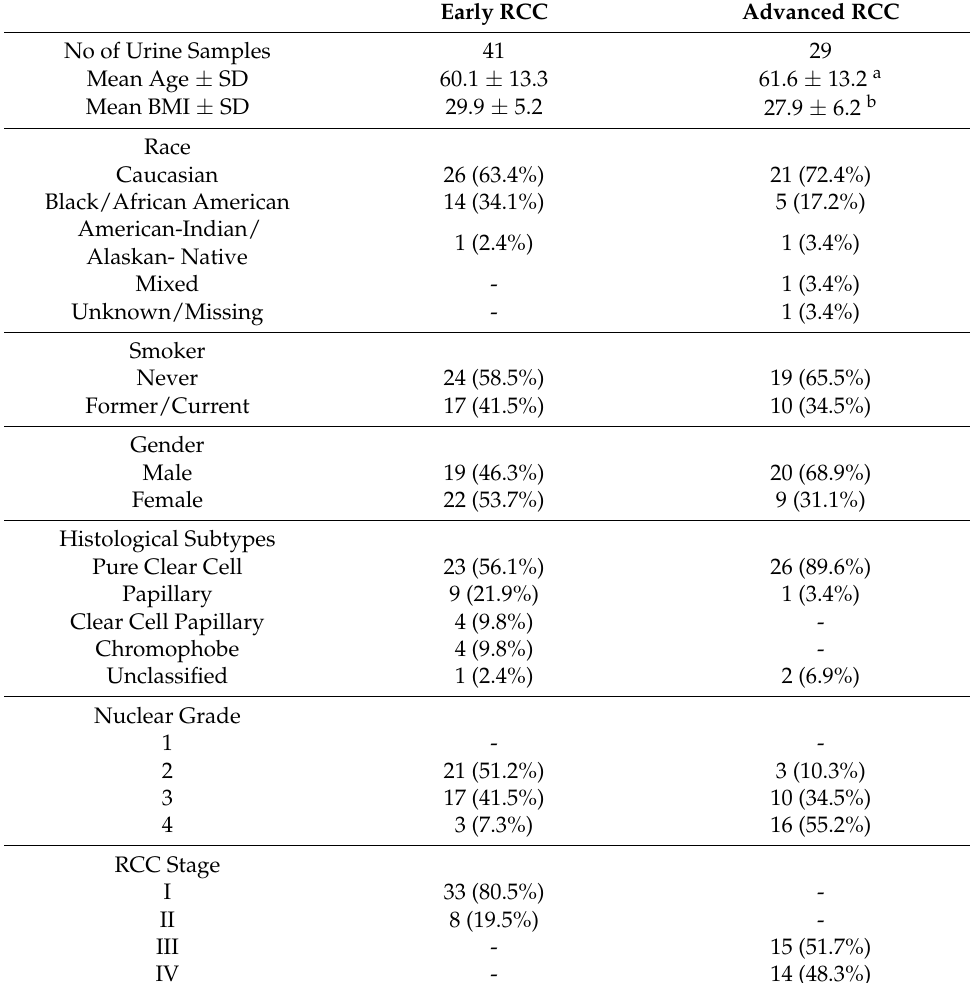
Table 1. Patient cohort